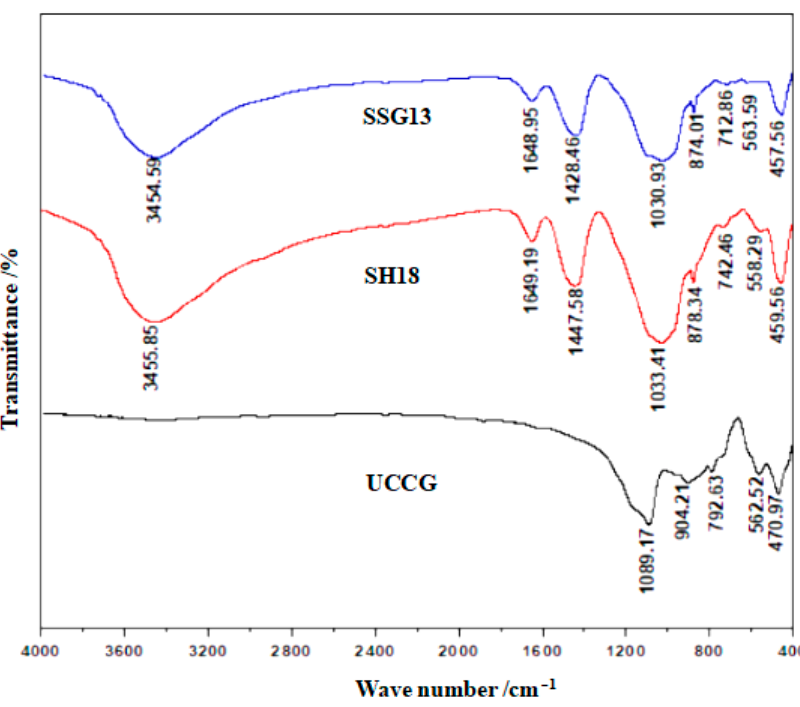
Figure 13. FTIR spectra of geopolymers with different activators.